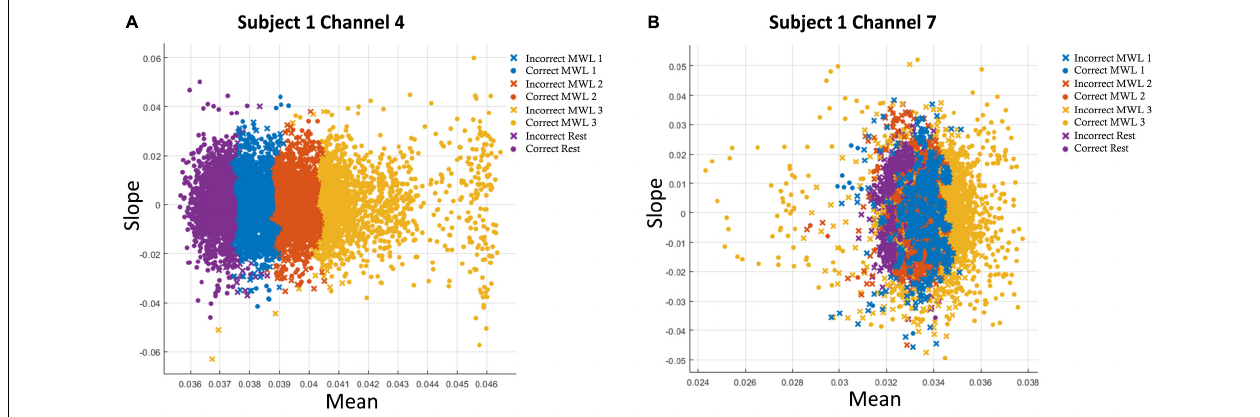
FIGURE 5 | (A) Accuracies with two-feature (mean–slope) combination in support vector machine (SVM) classification plot of oxyhemoglobin (HbO) for subject 1 on channel 4. (B) Accuracies with two-feature (mean–slope) combination in k -nearest neighbor ( k -NN) classification plot of HbO for subject 1 on channel 7. Only statistically significant channels are